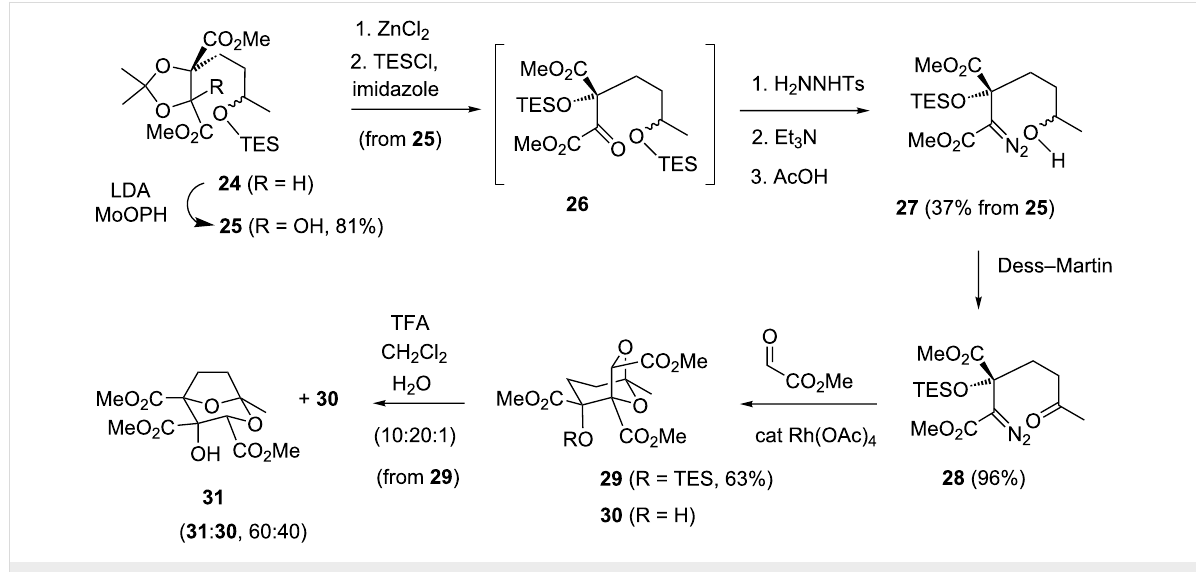
Scheme 7: TES protection approach to the squalestatin core.